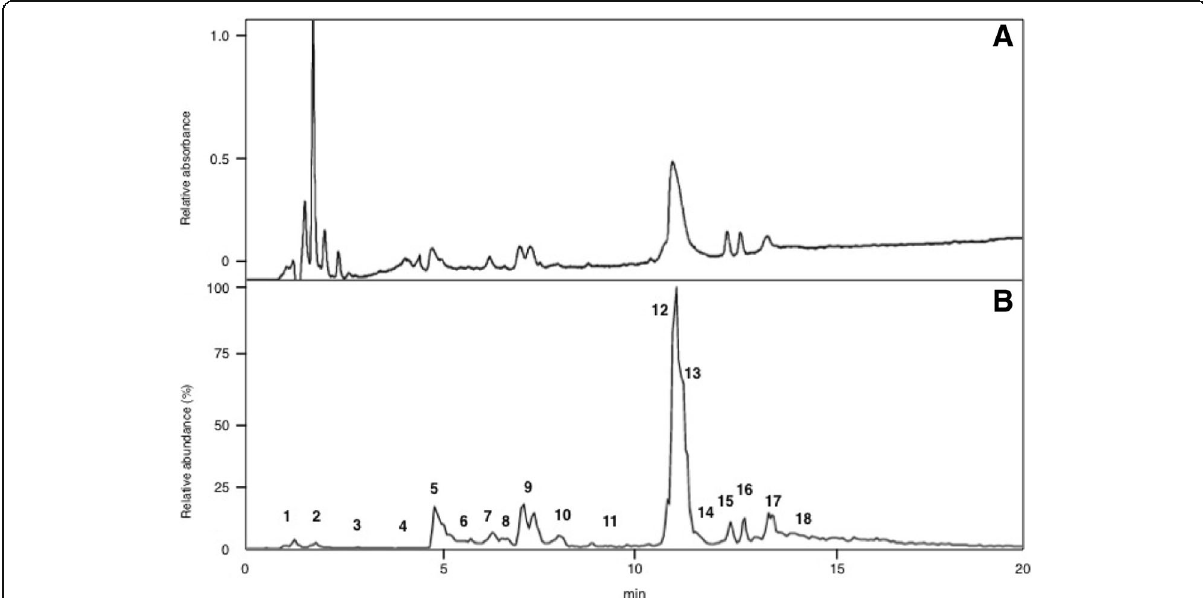
Fig. 1 LC-ESI-MS profile of crude venom extracts of Xylocopa appendiculata circumvolans . About 10% of crude venom extract of a single specimen was subjected to reverse-phase HPLC using CAPCELL PAK C 18 (1.5 × 150 mm) with linear gradient of 5 – 65% CH 3 CN/H 2 O/0.1% formic acid over 20 min at flow rate of 200 μ L/min. a UV absorption by PDA. b Total ion current (TIC). Numbers in B show “ virtual ” fraction number as in Tables 2 to